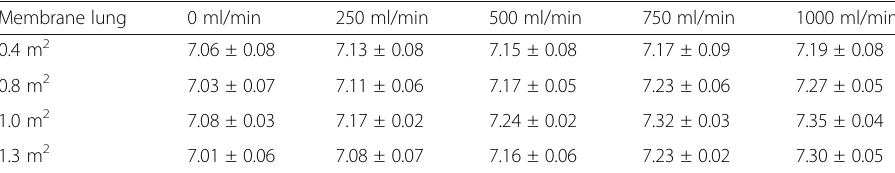
Table 1 pH value Membrane